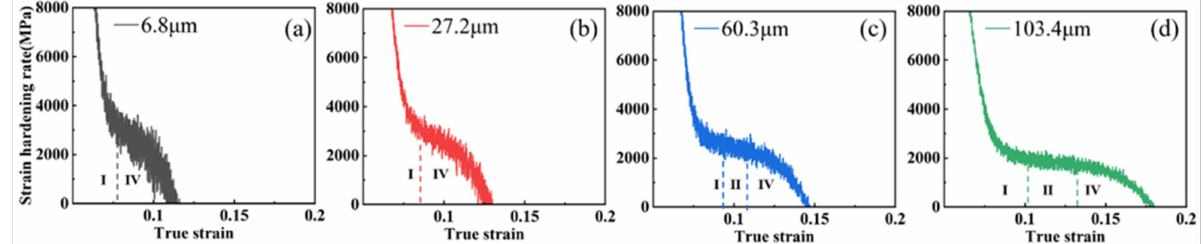
Figure 7. Work-hardening rate curves for each grain size sample at 40% reduction: ( a ) 6.8 µ m; ( b ) 27.2 µ m; ( c ) 60.3 µ m; ( d ) 103.4 µ